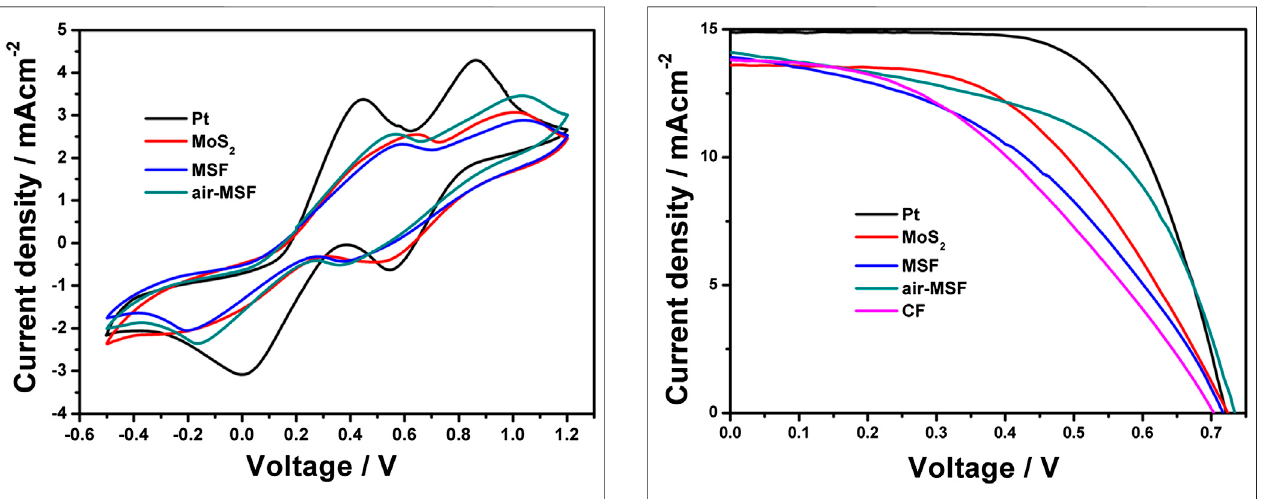
FIGURE7| J – V curves ofdye sensitizedsolarcellswithair-mesoporous silica nano fi ber (MSF), MSF, CF, MoS 2 , and Pt counter